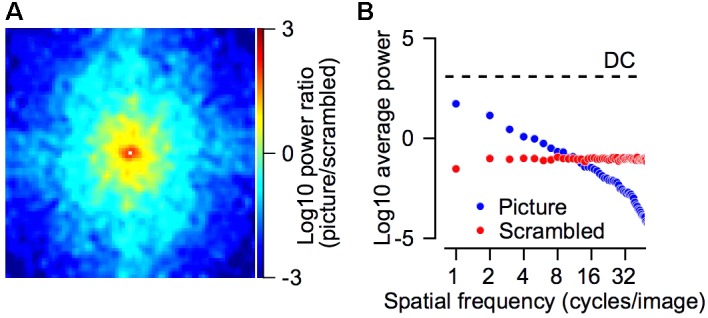
Power spectrum of the picture and scrambled stimuli. (A) The log10 of the ratio between the power spectrum of the picture and the scrambled target. Positive values (picture > scrambled) are represented by red/yellow pixels and negative values (picture < scrambled) in cyan/blue colors. The power spectrum was smoothed with a 2-dimensional Gaussian kernel (SD = 1 pixel). The DC component was removed from this plot and replaced by a small white square in the center of the plot. (B) The average power as a function of the spatial frequency for the picture (blue) and scrambled (red) stimuli. The dashed line regresses the DC component, which was equal for both stimuli. The spatial frequencies were calculated by transforming the power spectrum into polar coordinates (see section “Materials and Methods”). (A,B) Shows the power spectrum of the grayscale image.